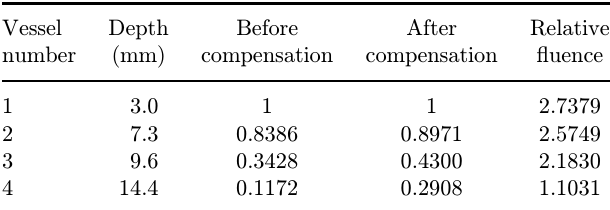
Table 2. Comparison of PA values before and after compensation.